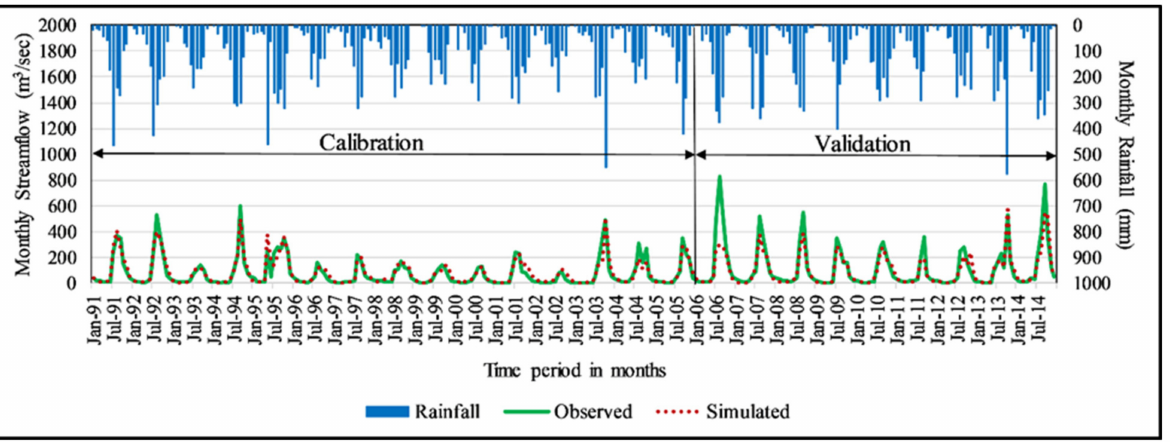
Figure 5. Observed versus simulated monthly streamflow during the calibration and validation period over the Vamsadhara river